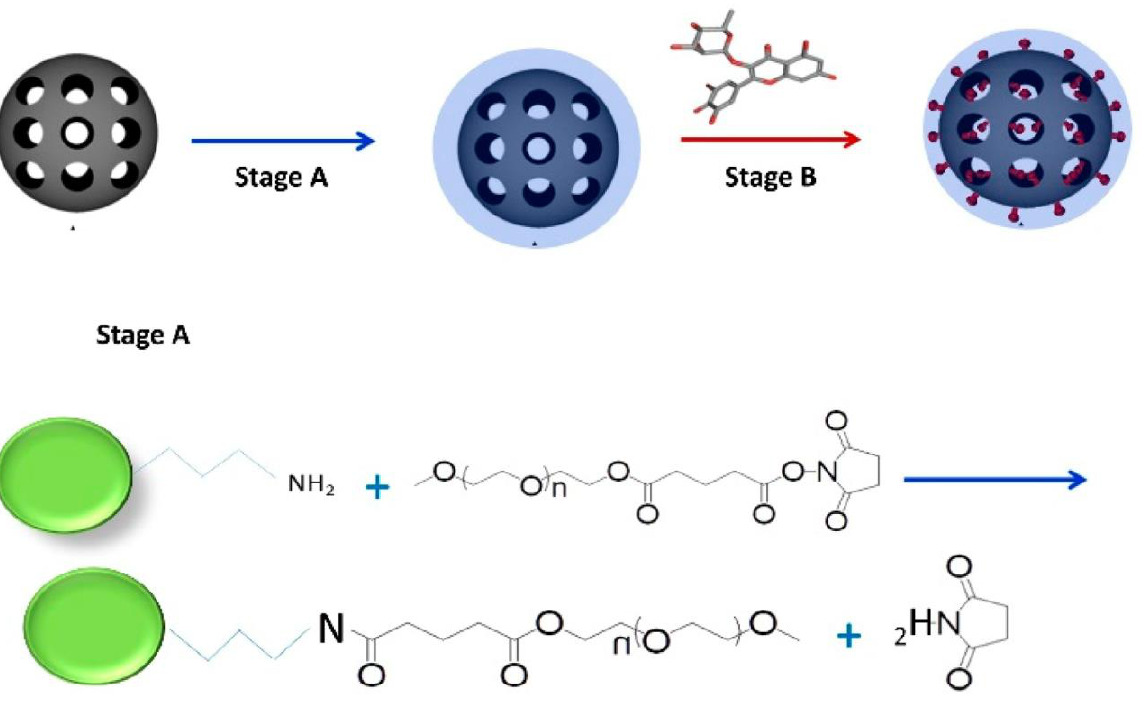
Figure 9. Synthesis of the flavonoid-loaded mesoporous silica nanoparticles (MSNs). Stage A: PEGylation of propylamine MSN; Stage B: Loading of flavonoids, adapted from [176], MDPI, 2019.